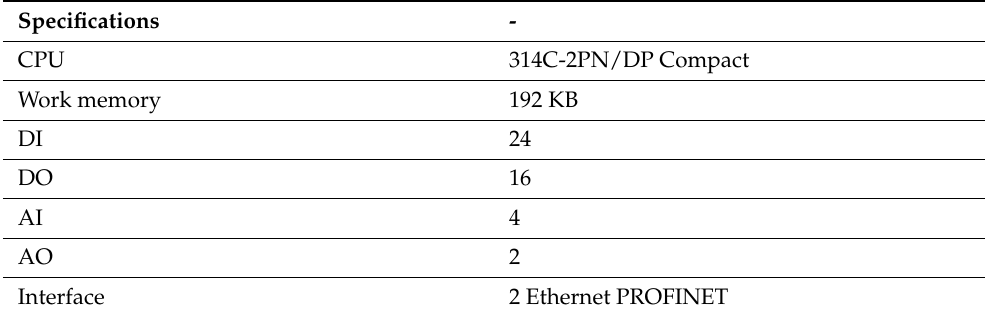
Table 3. Hardware specification of Siemens Simatic S7-300.